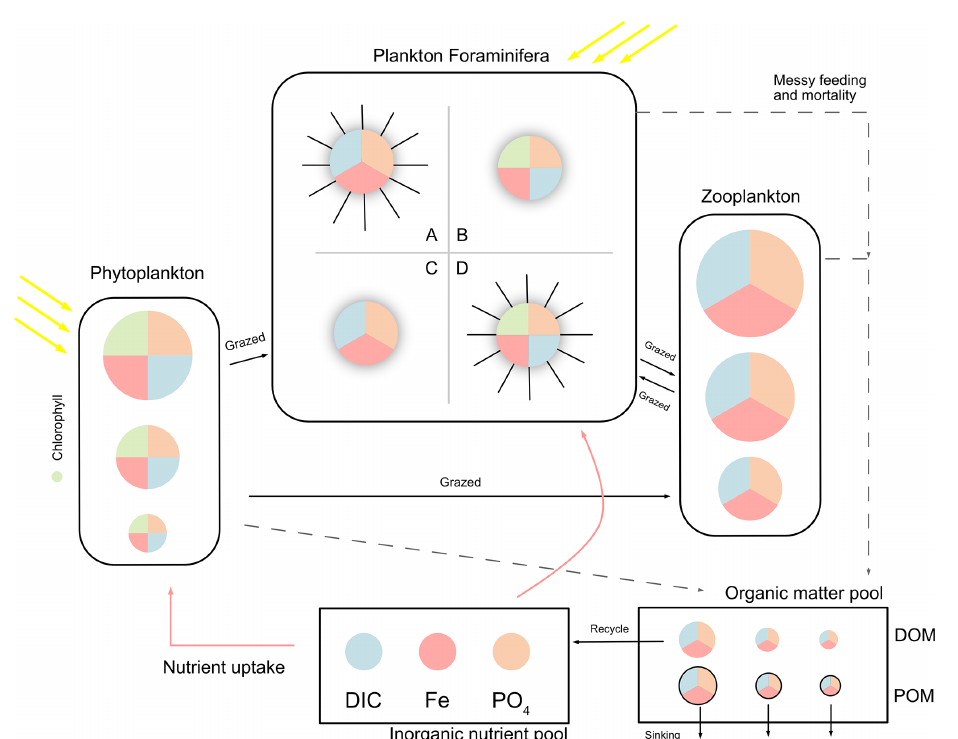
Figure 1. Schematic representation of the ForamEcoGEnIE 2.0 model structure. The model includes the biogeochemical cycles of C, Fe, and P (shown in different colours), various plankton size classes and four main groups of planktic foraminifera: A – symbiont-barren spinose group; B – Symbiont-facultative non-spinose group; C – symbiont-barren non-spinose group; D – symbiont-obligate spinose group. DIC stands for dissolved inorganic carbon and PO 4 for phosphate. The model represents nutrient uptake (red arrows), dissolved and particulate organic matter production (DOM and POM) caused by messy feeding and mortality (dashed arrows), and zooplankton grazing (black arrows).